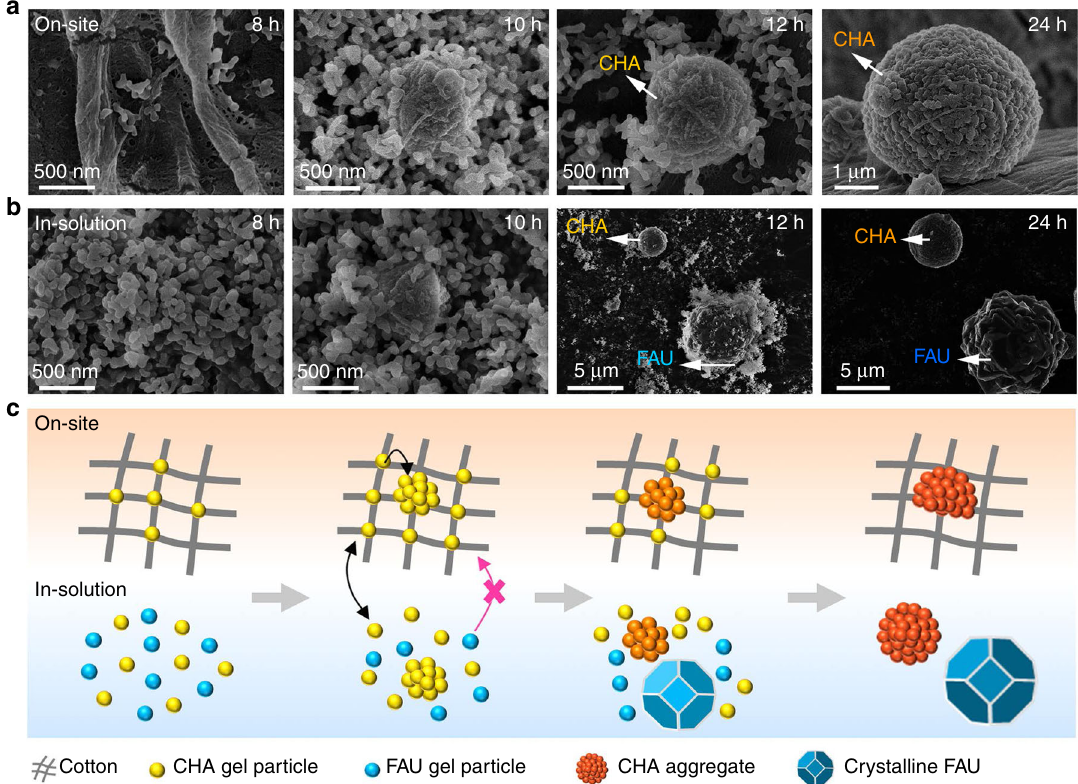
Fig. 2 Tentative mechanism of mCHA-C formation. FE-SEM images of the products ( a ) on site and ( b ) in solution at different time intervals, ( c ) schematic representation of formation process of on-site and in-solution